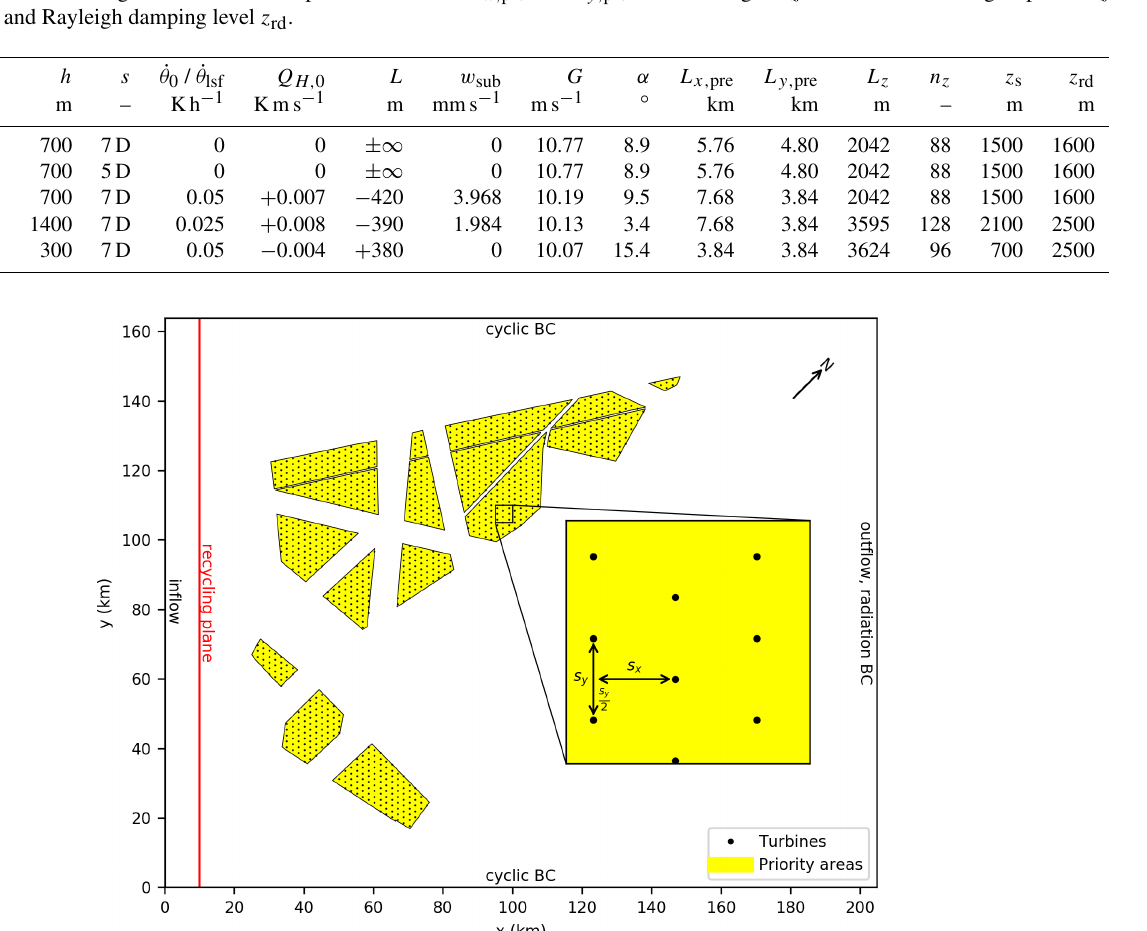
Figure 2. Domain and wind farm layout: inflow from left and turbulence recycling plane at x = 10km. Priority areas for future wind farms (see Fig. 1) are filled with a regular, staggered grid of wind turbines with a streamwise and crosswise turbine spacing of s x = s y = 7D (shown here) or